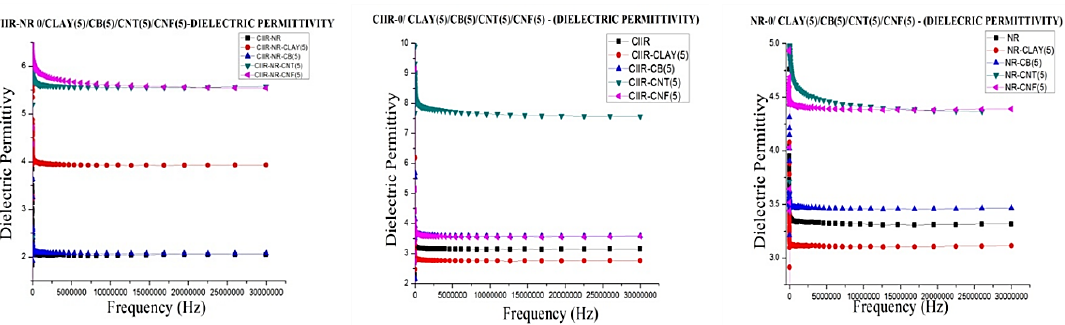
Figure 12. Frequency dependencies of dielectric permittivity of CIIR/NR blend, CIIR and NR rubber nanocomposites with different fillers.